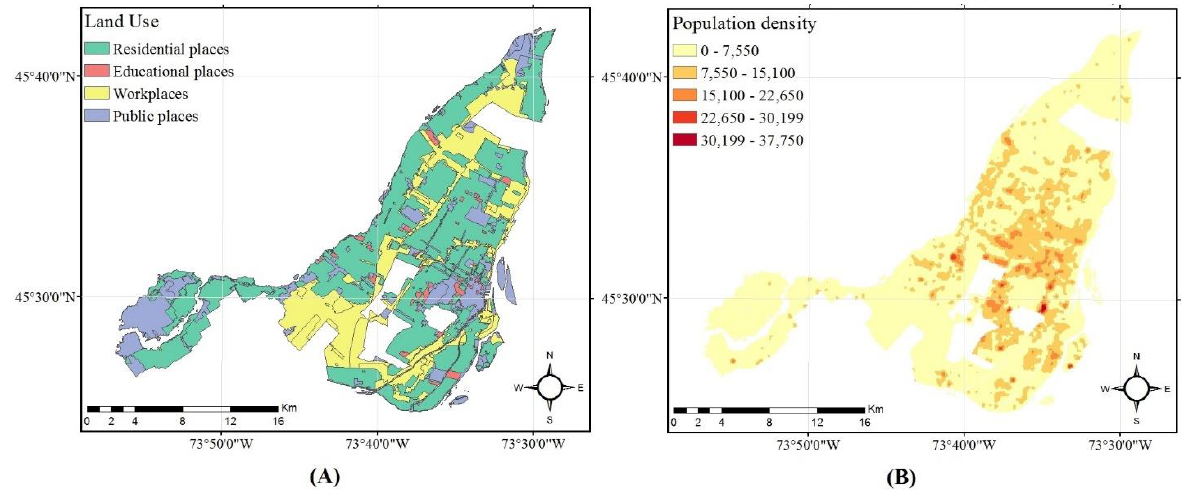
Figure 1. ( A )The land use of Montreal in four groups; and ( B ) the population density of Montreal.